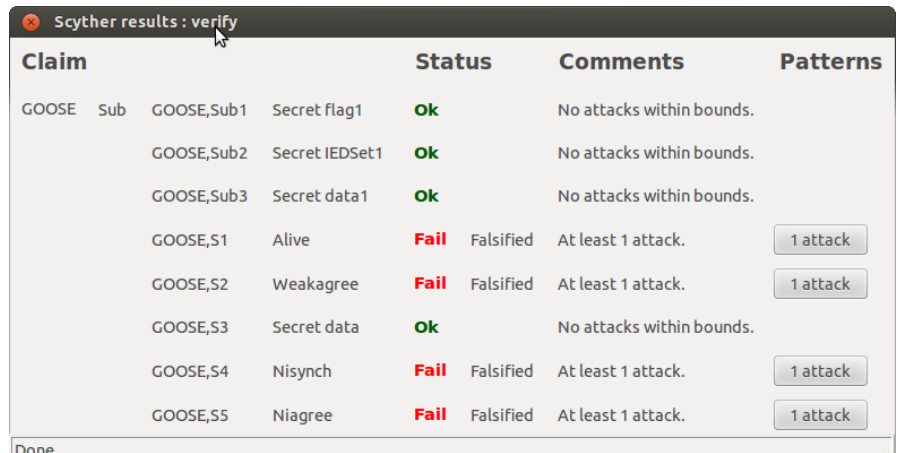
Figure 8. GOOSE security verification using Scyther.